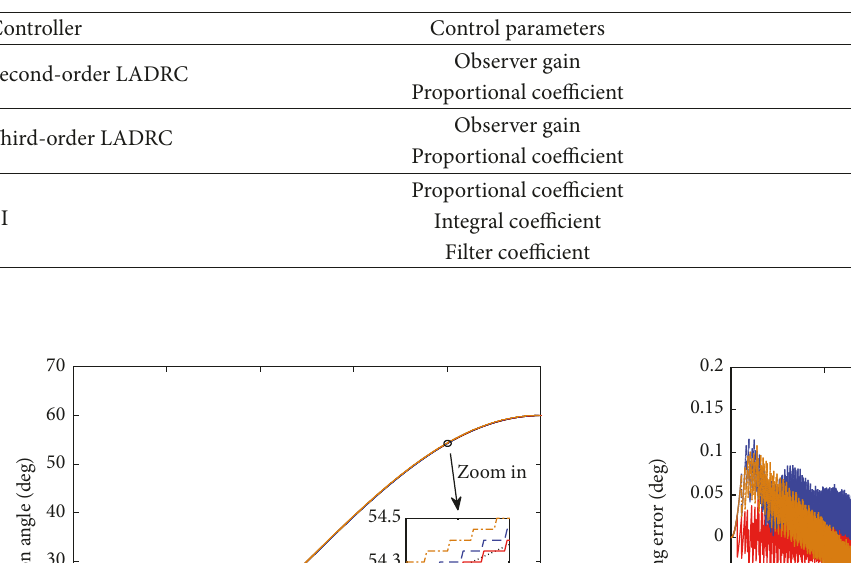
Table 2: Tuned control parameters of three controllers.